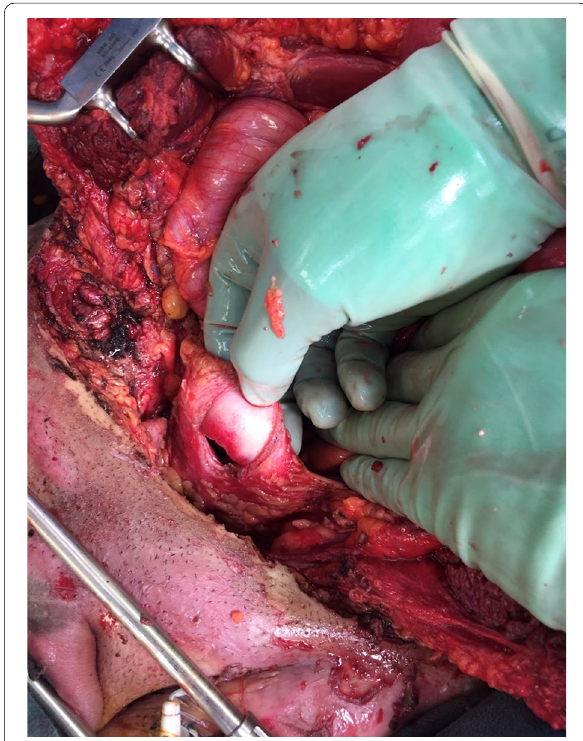
Fig. 7 Coagulative necrosis of bladder wall secondary to electrical